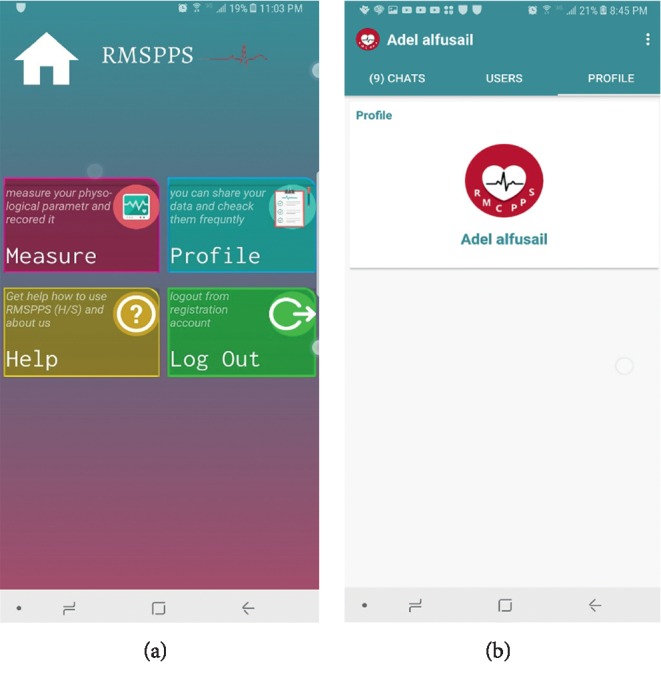
The menu interface of the patient application: (a) home screen of the patient application; (b) the patient account page.